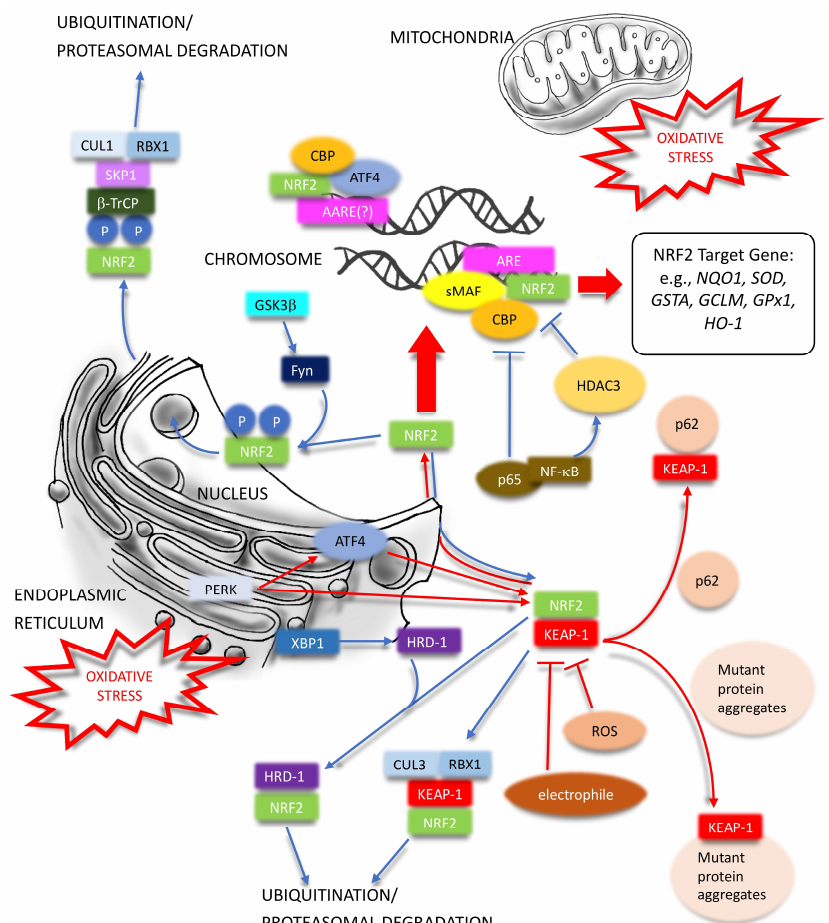
Figure 1. Diverse positive and negative control regulation of NRF2 expression (1). Red lines denote positive and blue ones represent negative. ATF4—activating transcription factor 4; AARE—amino acid response element; ARE—antioxidant response element; CBP—CREBP/cyclic adenosine monophosphate response element binding protein; CUL—cullin; Fyn—FYN Proto-Oncogene, Src Family Tyrosine Kinase; GSTA— glutathione S-transferase A; GCLM— glutamate-cysteine ligase modifier subunit; GPx1— glutathione peroxidase 1; GSK3β — glycogen synthase kinase-3β; HDAC3—histone deacetylase 3; HO-1— heme oxygenase-1; HRD1—SYVN1/synoviolin E3 ubiquitin ligase; KEAP1— Kelch-like ECH-associated protein 1; NF-κB—nuclear factor kappa-light-chain-enhancer of acti-